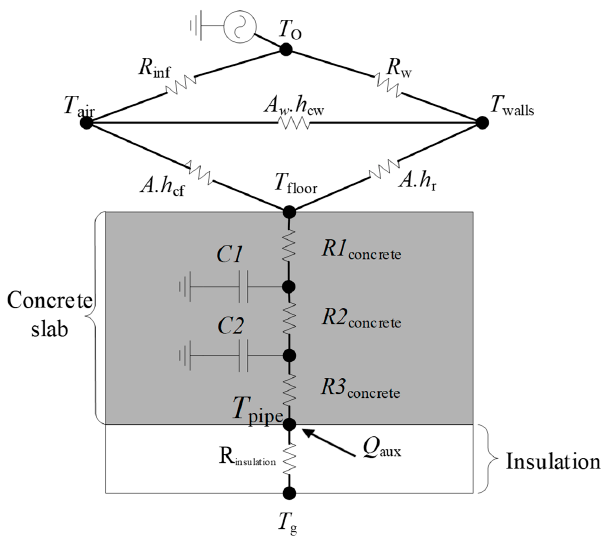
Figure 2. Second-order model thermal network of floor heating system.